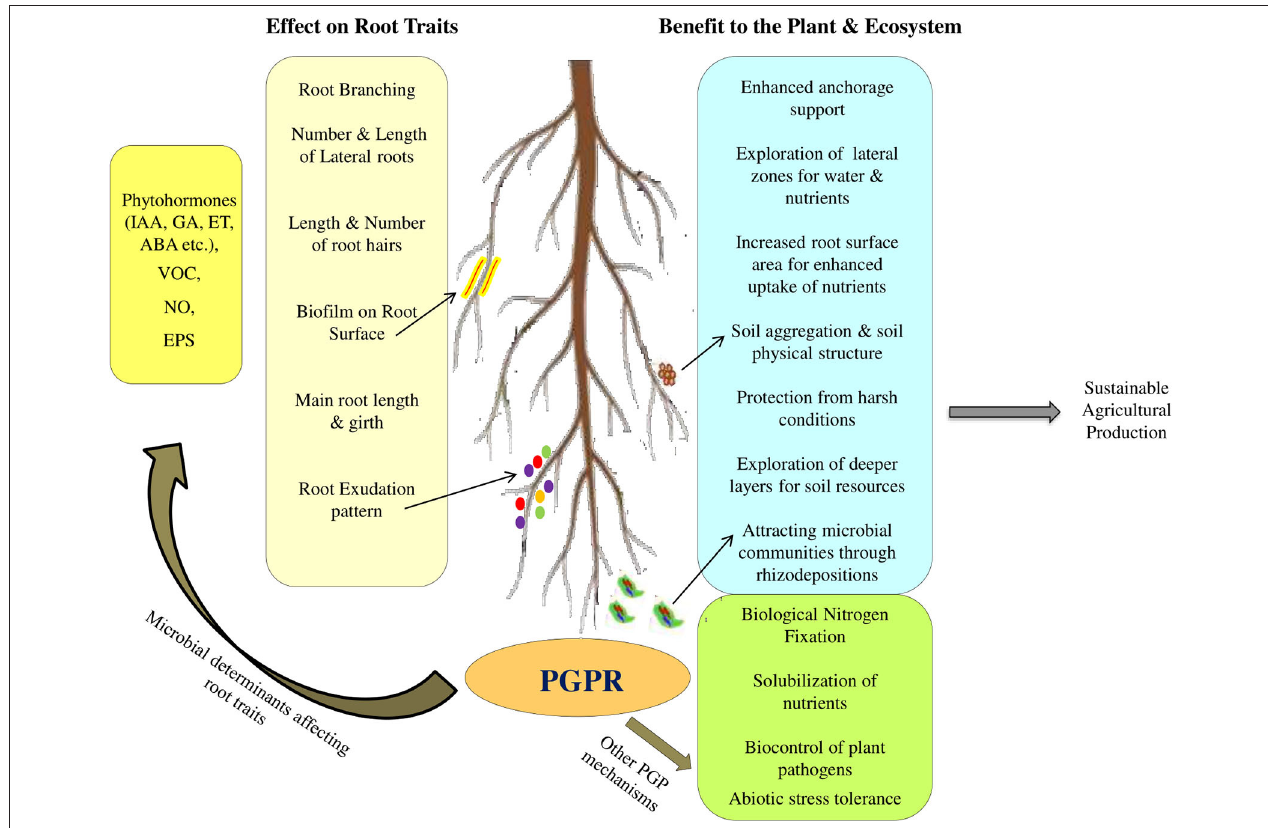
FIGURE 4 | Conceptual presentation of PGPR mediated changes in root traits and the corresponding effects on plant growth and ecosystem